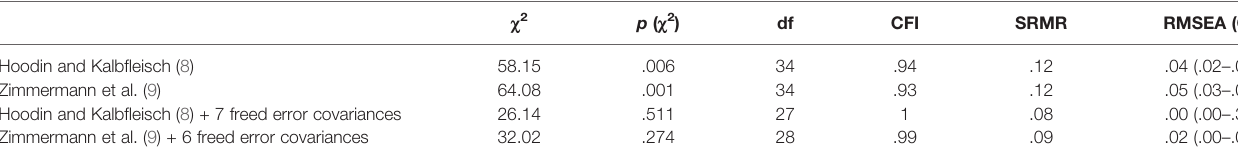
TABLE 2 | Model fi t indices of the CFA-models.